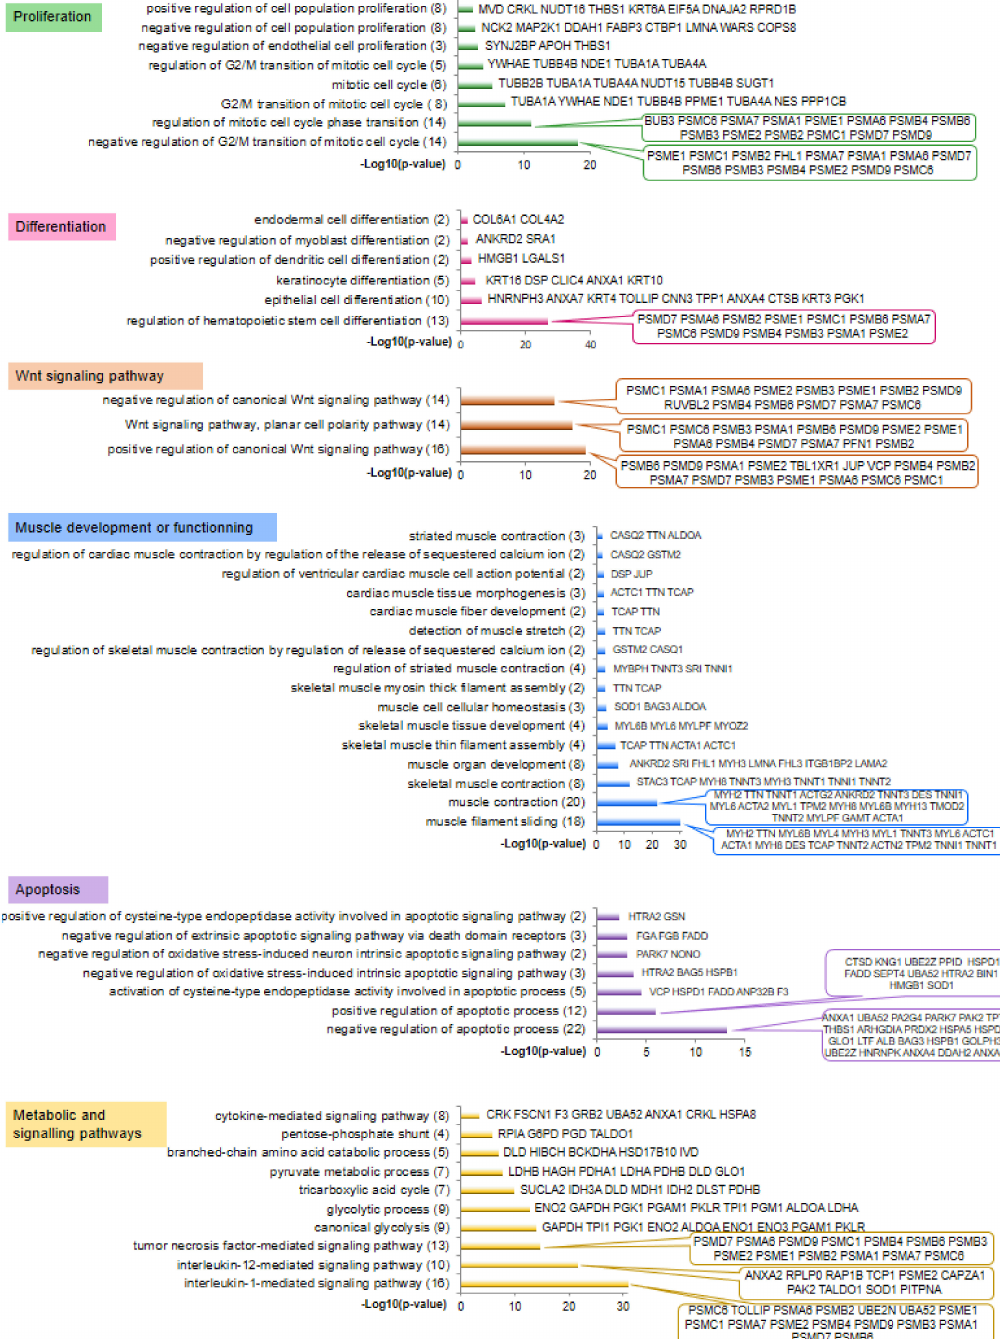
Figure 1. A focus on the most significantly enriched Gene Ontology (GO) terms that annotated proteins identified in the fetal muscles (both Semitendinosus and Longissimus thoracis muscles) at 140 days post-conception. GO terms were grouped by major biological functions. Results were obtained with ProteINSIDE and enrichments are expressed as − log 10 ( p -value) for visualization on graphs, which means that log 10 values of ( p -value) of 3, 2, and 1.3 correspond to p -values of 0.001, 0.01, and 0.05, respectively. The total number of proteins annotated by GO terms is shown in